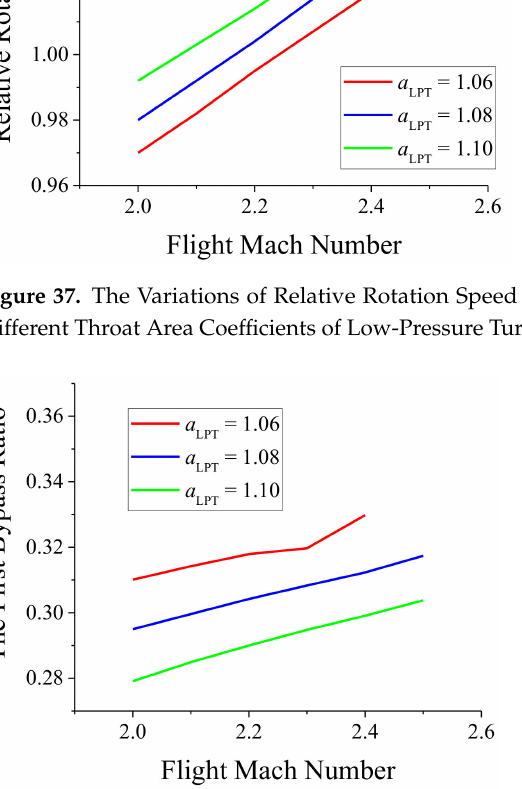
Figure 38. The Variations of The First Bypass Ratio at the conditions of Different Throat Area Coefficients of Low-Pressure Turbine Inlet Guide Vane ( α LPT